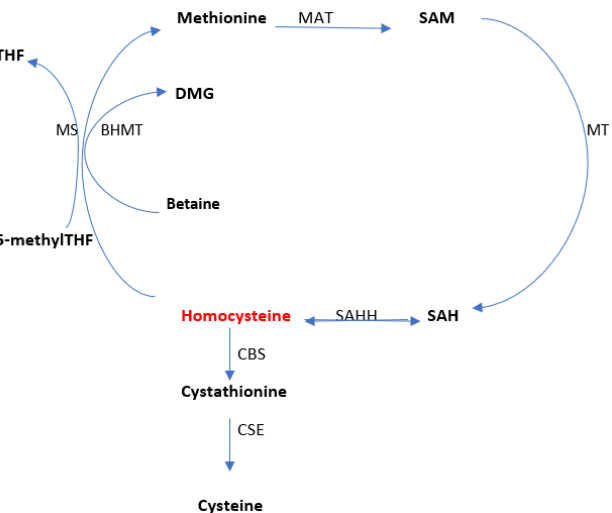
Figure 2. The overview of homocysteine metabolism. Methionine adenosyltransferase (MAT); methyltransferase (MT); S-adenosylhomocysteine hydrolase (SAHH); betaine-homocysteine S-methyl transferase (BHMT); Cystathionine β -synthase (CBS); Cystathionine γ -lyase (CSE); methionine syn- thase (MS). Adapted from Moretti et al., [34].